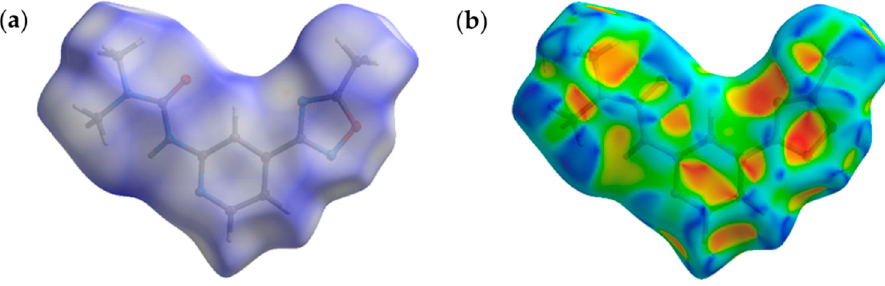
Figure 3. The Hirshfeld surfaces for 1a , mapped with d norm over the range –0,20 (red) to 1,00 (blue) ( a ) moieties; shape index (S), mapped from –1,0 (concave hollows; red) → 0,0 (minimal saddle; green) → +1,0 (convex bumps; blue) ( b ). 2.3. Noncovalent Bonding Patterns The further consideration of the HSA data suggests the existence of several types of intermolecular noncovalent contacts in structures of ( 1 – 3 ) a , b besides multiple hydrogen bonds. All structures display nontrivial interactions involving 1,2,4- or 1,3,4- oxadiazole core. Depending on the dialkyl substituents at urea moieties in ( 1 – 3 ) a , b , the XRD struc- tures display either (oxadiazole)···(pyridine) (Figure 4a) or (oxadiazole)···(oxadiazole) (Figure 4b) interaction. All these interactions could be identified as π – π interactions ac- cording to their distance and angular parameters (Table 1, Figure 5). The structures of 1a , b with dimethyl substituted urea display π ··· π (oxadiazole)···(pyridine) interactions, whereas 2a , b are prone to form (oxadiazole)···(oxadiazole) interactions. In addition, the lp– π